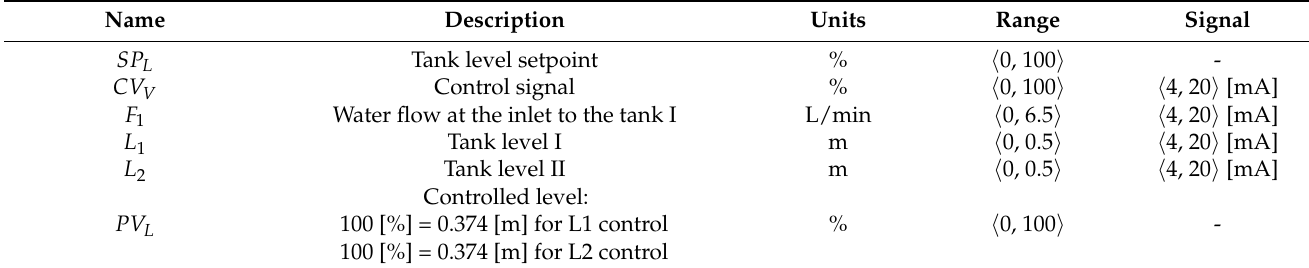
Table 1. Set of available process variables.